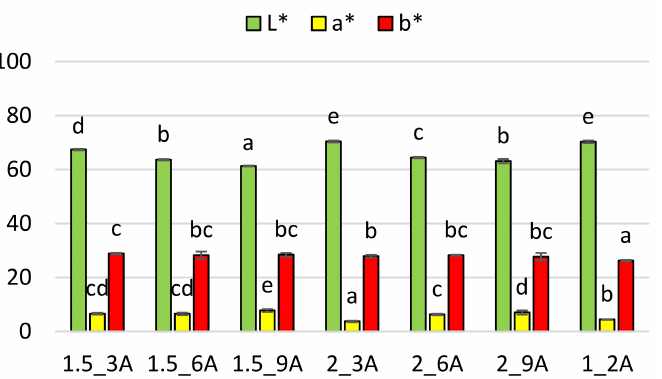
Figure 2. The effect of the amount of hydrocolloid and pomace addition on the colour in freeze-dried fruit bars with apple pomace. Mean values marked with the same index letter (a–e) do not differ statistically significantly at the level of p = 0.05. Denotations in Table 1 include Index (A) next to the sample symbol—bars with the apple pomace.